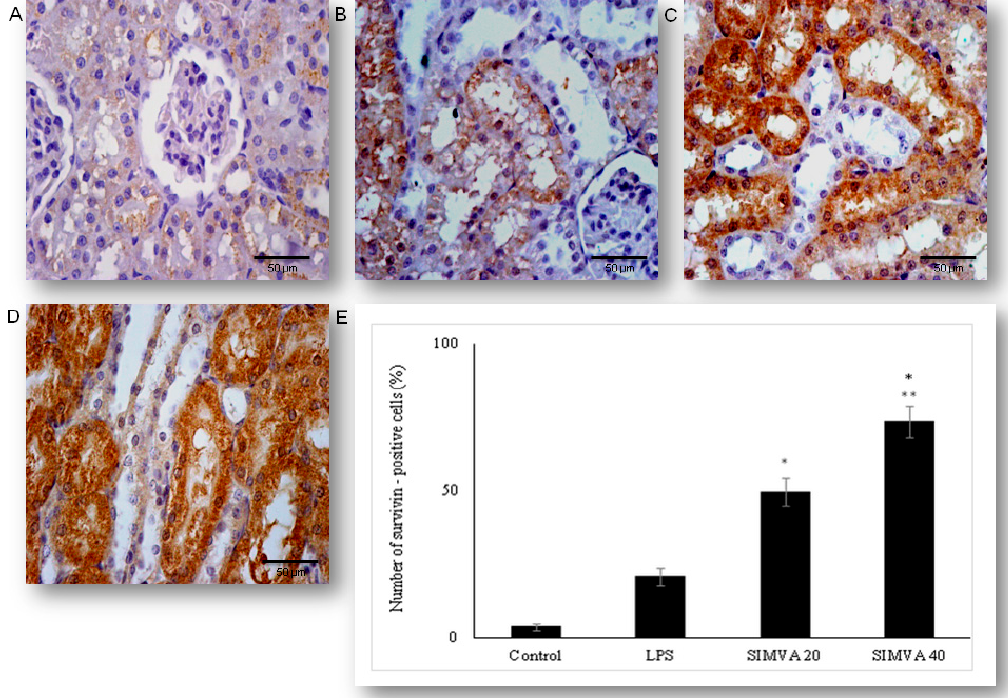
Figure 8. Simvastatin increased survivin expression in renal tubular epithelial cells after LPS administration. The expression of survivin in renal tissue examined by immunohistochemical staining, magnification 400 × , ( A ) the control group showed rare immuno-positive cell, ( B ) note immuno-positive survivin cells in the LPS group, in simvastatin 20 group ( C ), and simvastatin 40 group ( D ), survivin expression significantly increased, and it is determined as intensive brown cytoplasmic staining widely distributed in renal tubular epithelial cells. ( E ) A quantitative analysis of survivin-positive renal tubular epithelial cells assessed in immunohistochemically stained sections of the renal tissue (* p < 0.01 vs. LPS group, ∗∗ p < 0.05 vs. simvastatin 20